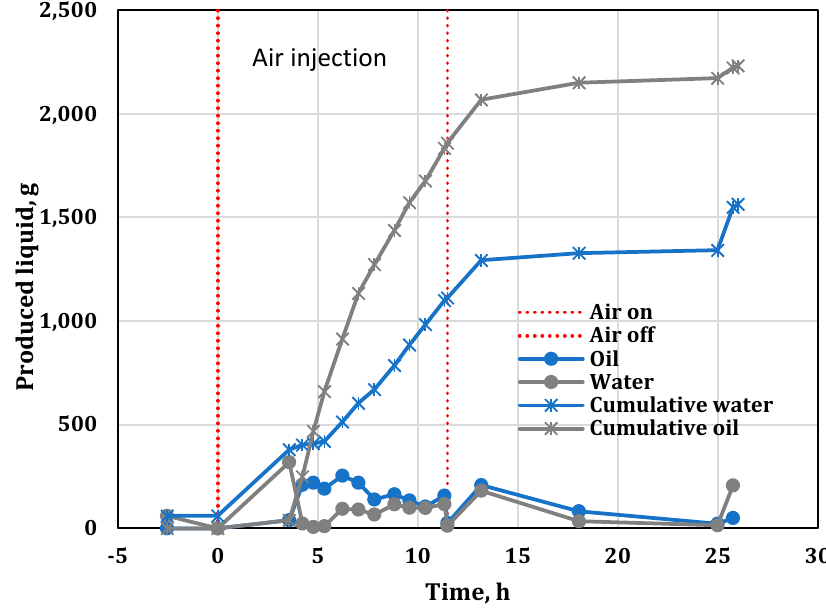
Figure 15. Water and oil production (incremental and cumulative).